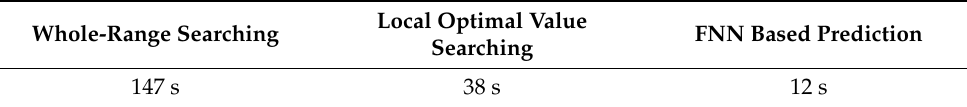
Table 3. Average search time statistics.